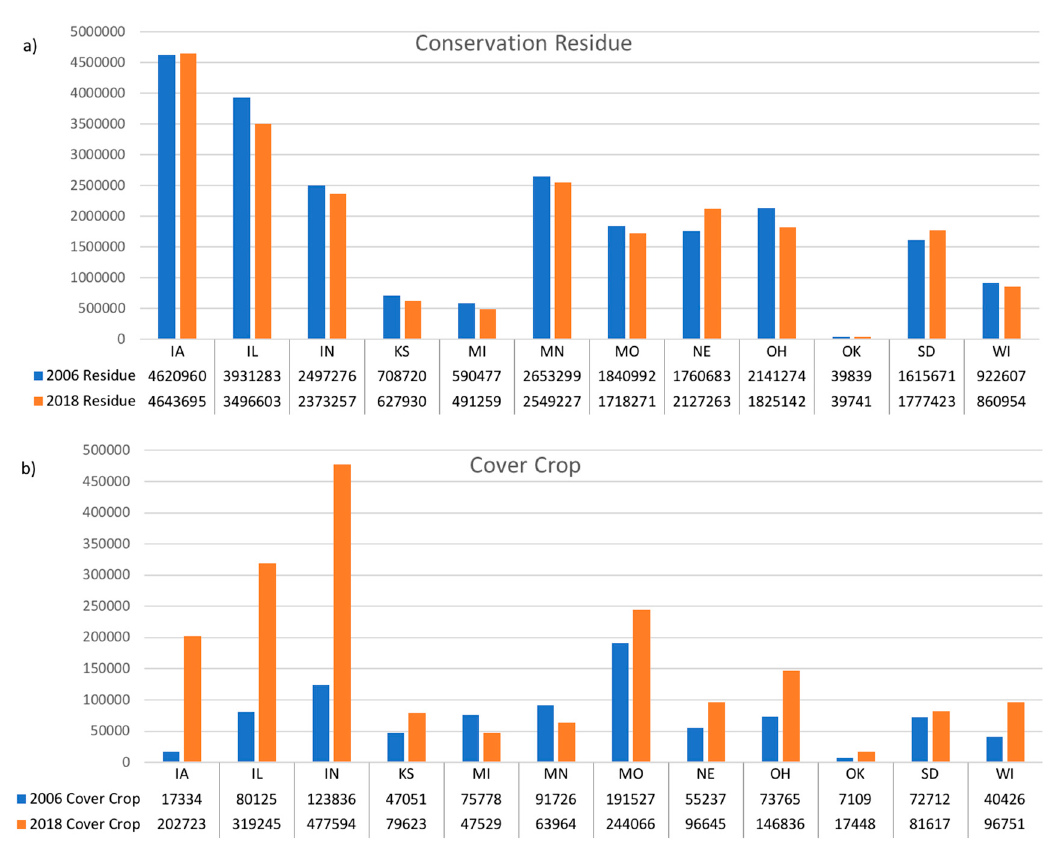
Figure 8. Comparison of statewide hectares of ( a ) conservation tillage practices and ( b ) total cover crops planted for the years 2006 and 2018.